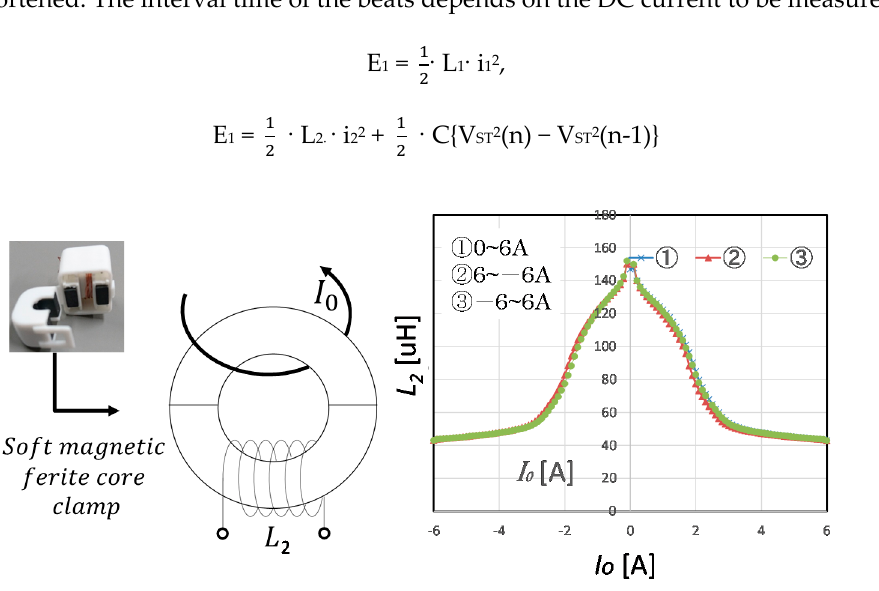
Figure 3. Measured inductance of the soft magnetic ferrite core clamp. The inductance depends on the DC Current which flows through the